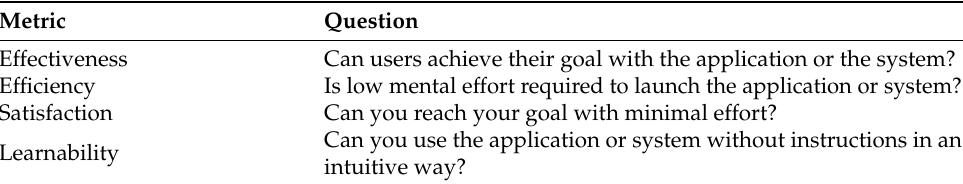
Table 16. Basic usability and user experience metrics.